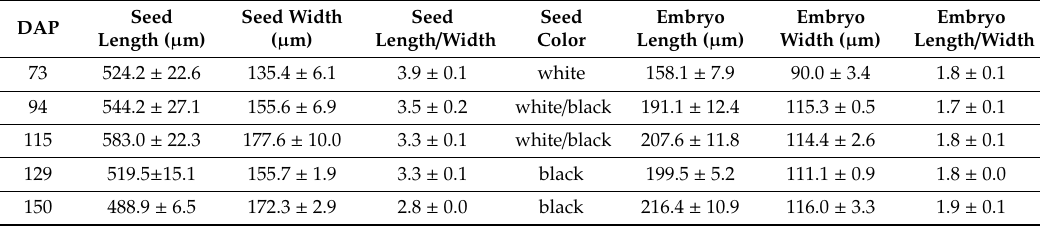
Table 1. The size of seed and embryo at di ff erent developmental stages of P. armeniacum . The seed dimension was measured from SEM images, and the embryo dimension was measured from optical microscope images. n = 3; ± SD. The size of seed and embryo is calculated from three independently grown biological replicates. In each replicate, approximately 30 seeds were